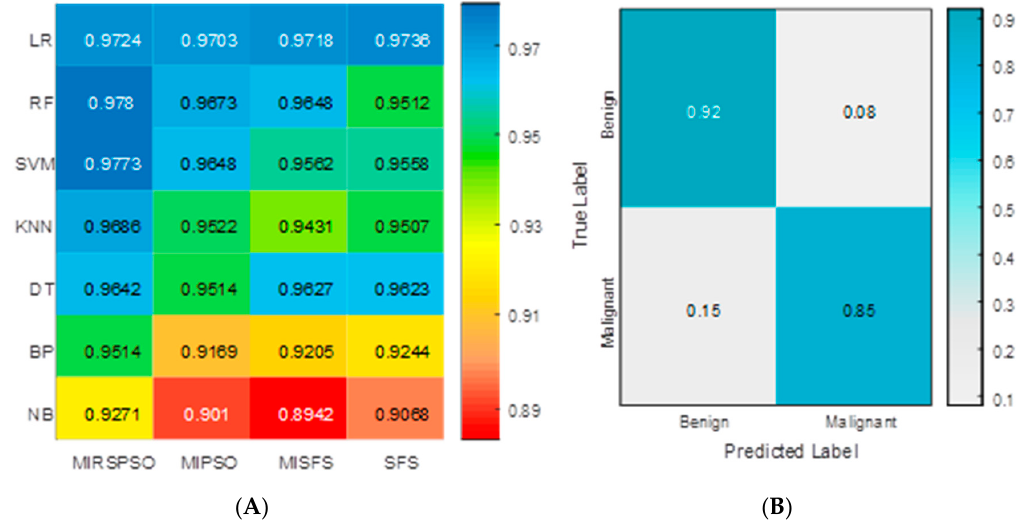
Figure 4. Predictive performance of the constructed classifier in the test cohort. ( A ) Heatmap depicting the prognostic performance (AUC) of feature selection (in rows) and classification (in columns) methods. It depicts the mean AUC of all the crossed methods, along with standard deviation (SD) and the 0.25 and 0.75 (the quantile values). It can be observed that MIRSPSO + RF, MIRSPSO + SVM had the highest Cancers 2019 , 11 , x FOR PEER REVIEW values of AUC. ( B ) Confusion matrix with the MIRSPSO + RF classifier.